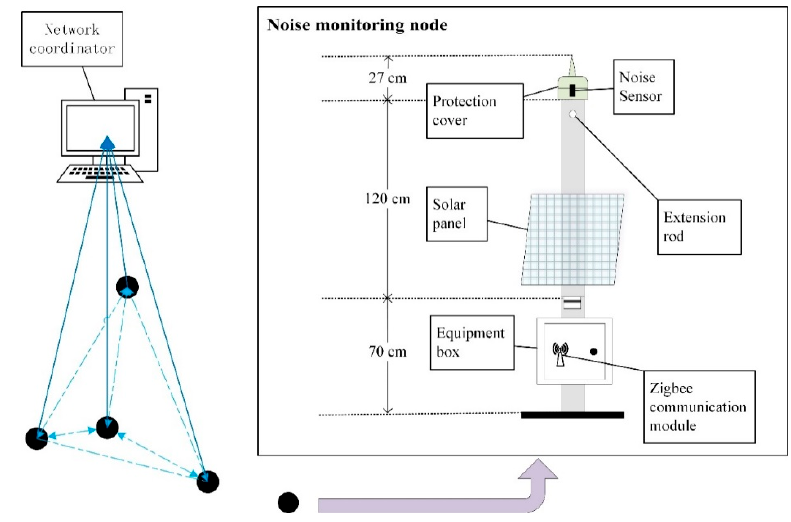
Figure 1. Noise monitoring system based on IoT.